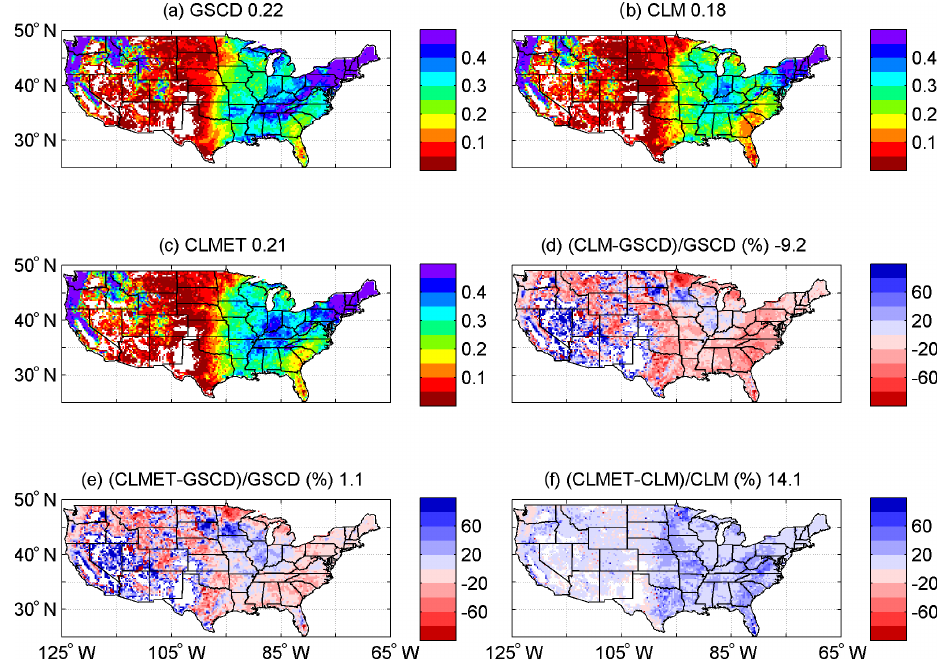
Figure 11. Mean annual runoff coefficient (the ratio runoff to total precipitation) from (a) the Global Streamflow Characteristics Dataset (GSCD), (b) the CLM, and (c) CLMET, and the relative differences between (d) the CLM and GSCD, (e) CLMET and GSCD, and (f) CLMET and the CLM during the period 2000–2014. Runoff coefficients of less than 0.02 are blanked out. Numbers in titles are CONUS- averaged